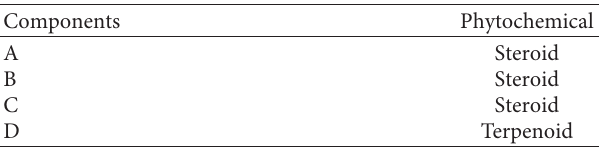
Table 10: Phytochemical screening result for collected fractions of methanol extracts of V.